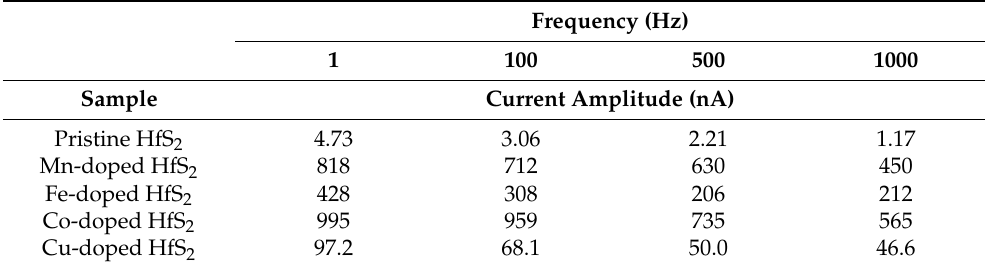
Table 5. Current amplitudes of the pristine, Mn-, Fe-, Co-, and Cu-doped HfS 2 crystals under different illumination